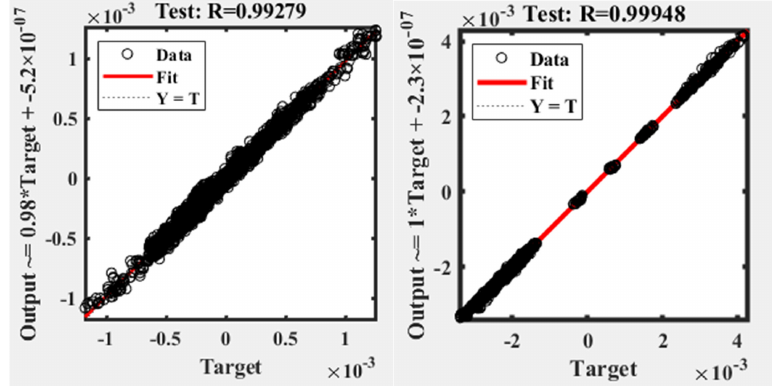
Figure 15. Test outputs for the y and z strains.